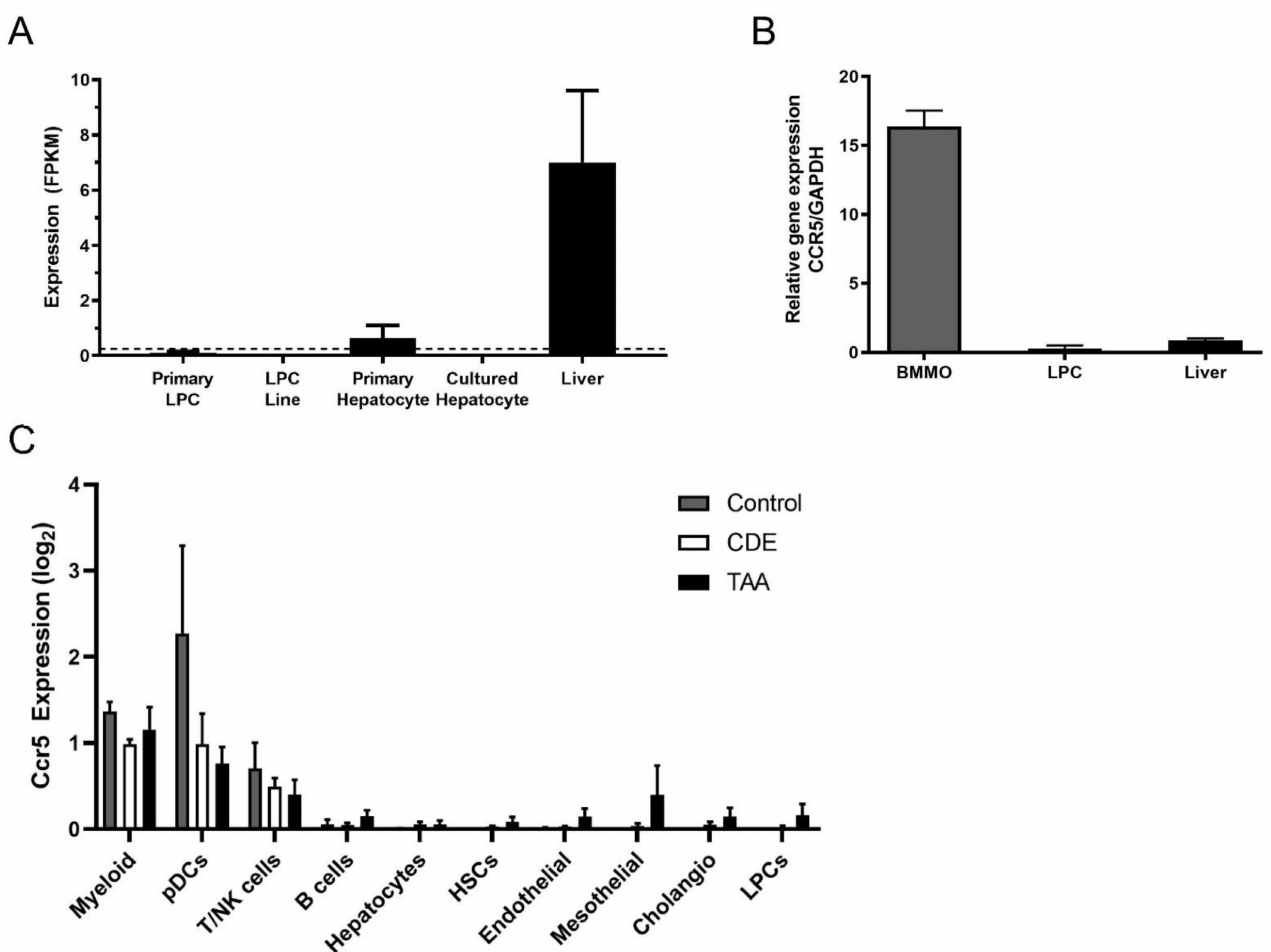
Figure 5. Inflammatory cells express high levels of Ccr5 , and LPCs do not. ( A ) Expression of Ccr5 was examined by RNA-Seq in primary LPCs, LPC lines, primary and cultured hepatocytes and whole normal murine liver. Expression values are provided as fragments per kilobase of transcript per million mapped reads (FPKM). A dotted threshold was placed at FPKM = 0.25 to indicate the level above which a gene may be considered actively expressed. Bars represent means + SEM n = 3, 12, 3, 3 and 3 for primary LPC cultures, LPC lines, primary hepatocyte cultures, cultured hepatocytes and liver tissue, respectively. ( B ) RT-PCR was performed to amplify Ccr5 and the GAPDH loading control, using cDNA from BMMOs, LPCs and murine liver. ( C ) Single-cell Ccr5 expression analysed by snRNA-Seq in Control, CDE-treated and TAA-treated livers. Ten major hepatic cell types were identified and log2-transformed Ccr5 expression reported for every cell type in each treatment group. Bars represent mean ± SEM. Myeloid (macrophages and monocytes), pDCs (plasmacytoid dendritic cells), T/NK (T cells and natural killer cells), HSCs (hepatic stellate cells), Cholangio (cholangiocytes), LPCs (liver progenitor